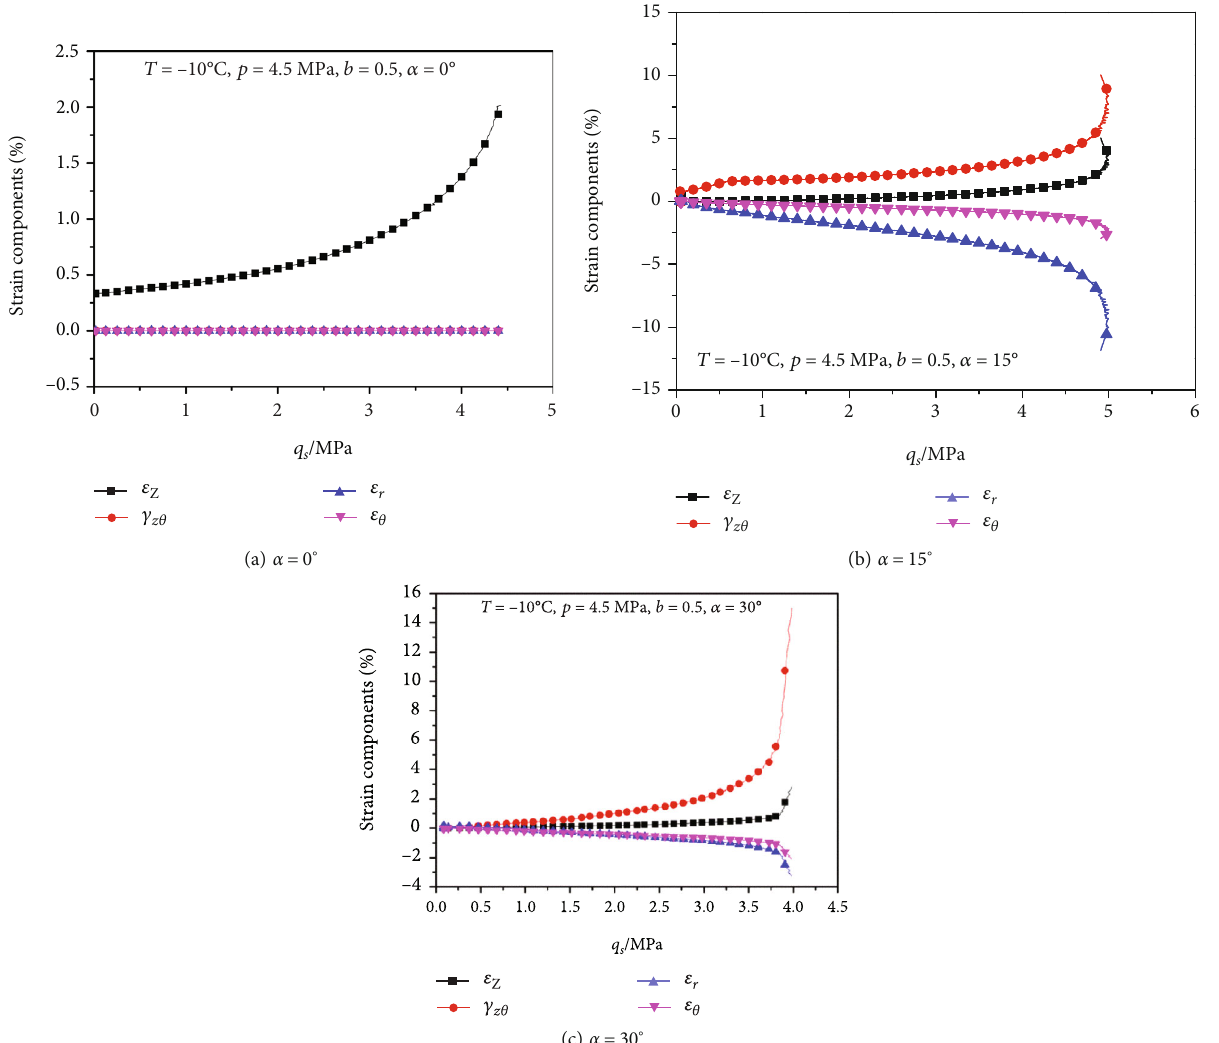
Figure 9: Relationships between shear stress and strain components of the